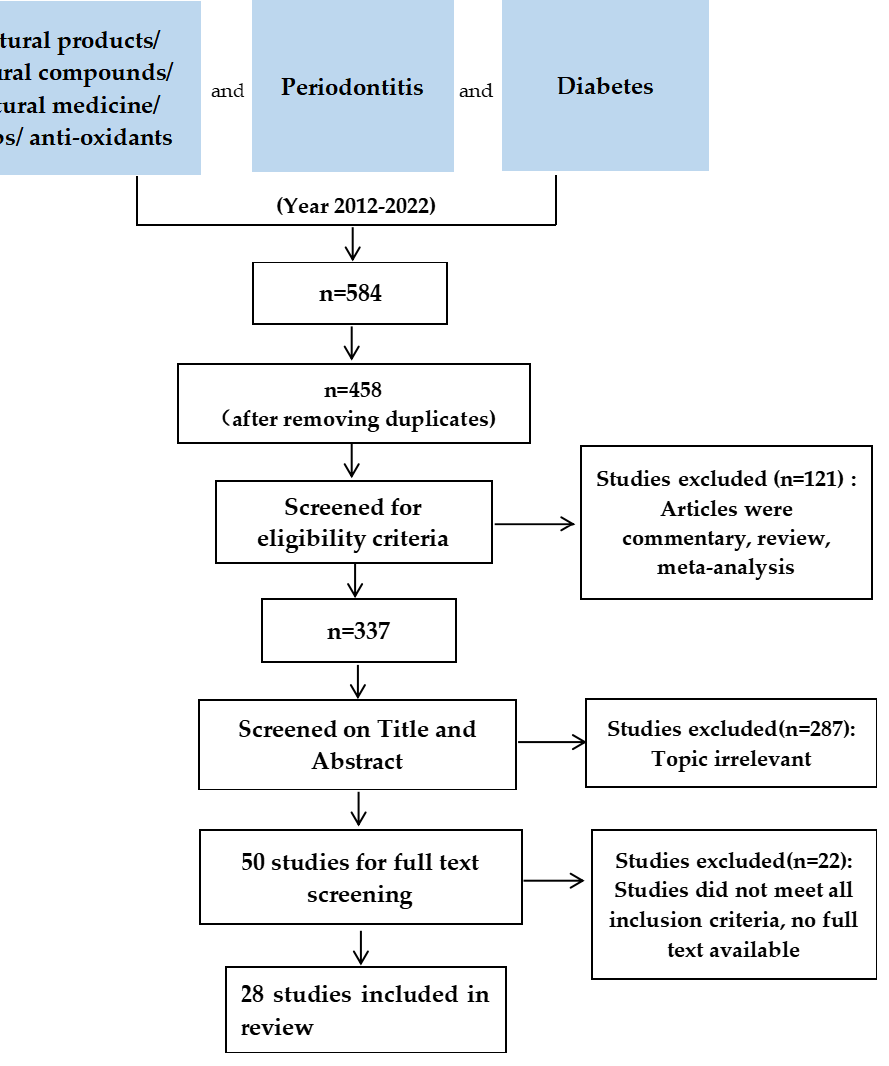
Figure 1. Study selection flow chart.